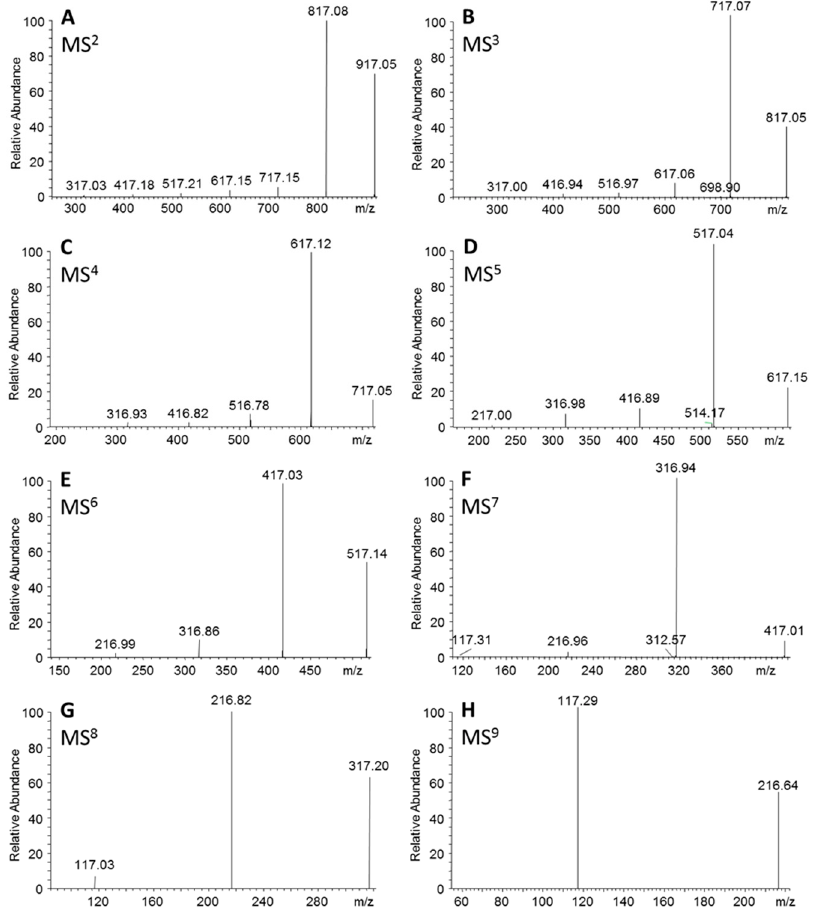
Figure 8. ESI ‐ MS n spectra (negative ion mode) of poly( δ ‐ valerolactone) precursor ion at m/z 917 and the respective parent ions with different chain length (MS 2 (A)–MS 9 (H)), (Sample 1, Table 1).